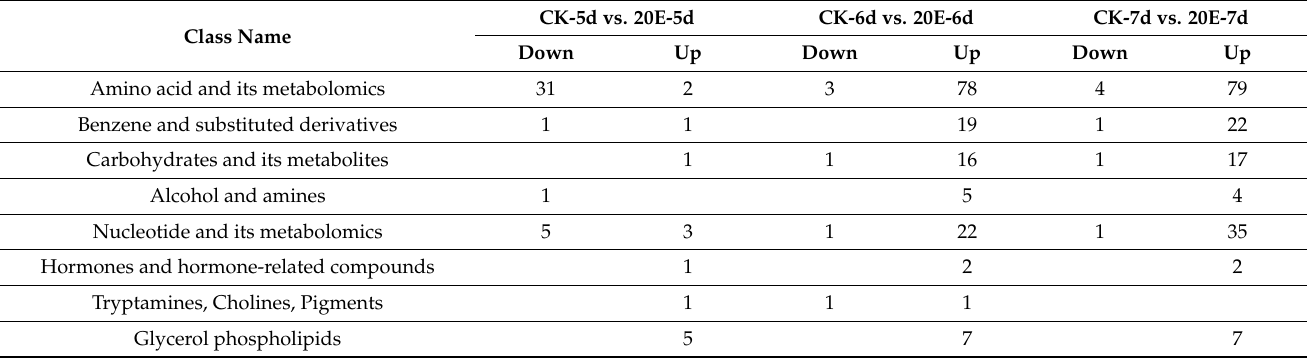
versus 20E-6d and CK-7d versus 20E-7d, the overlapping metabolites were analyzed by